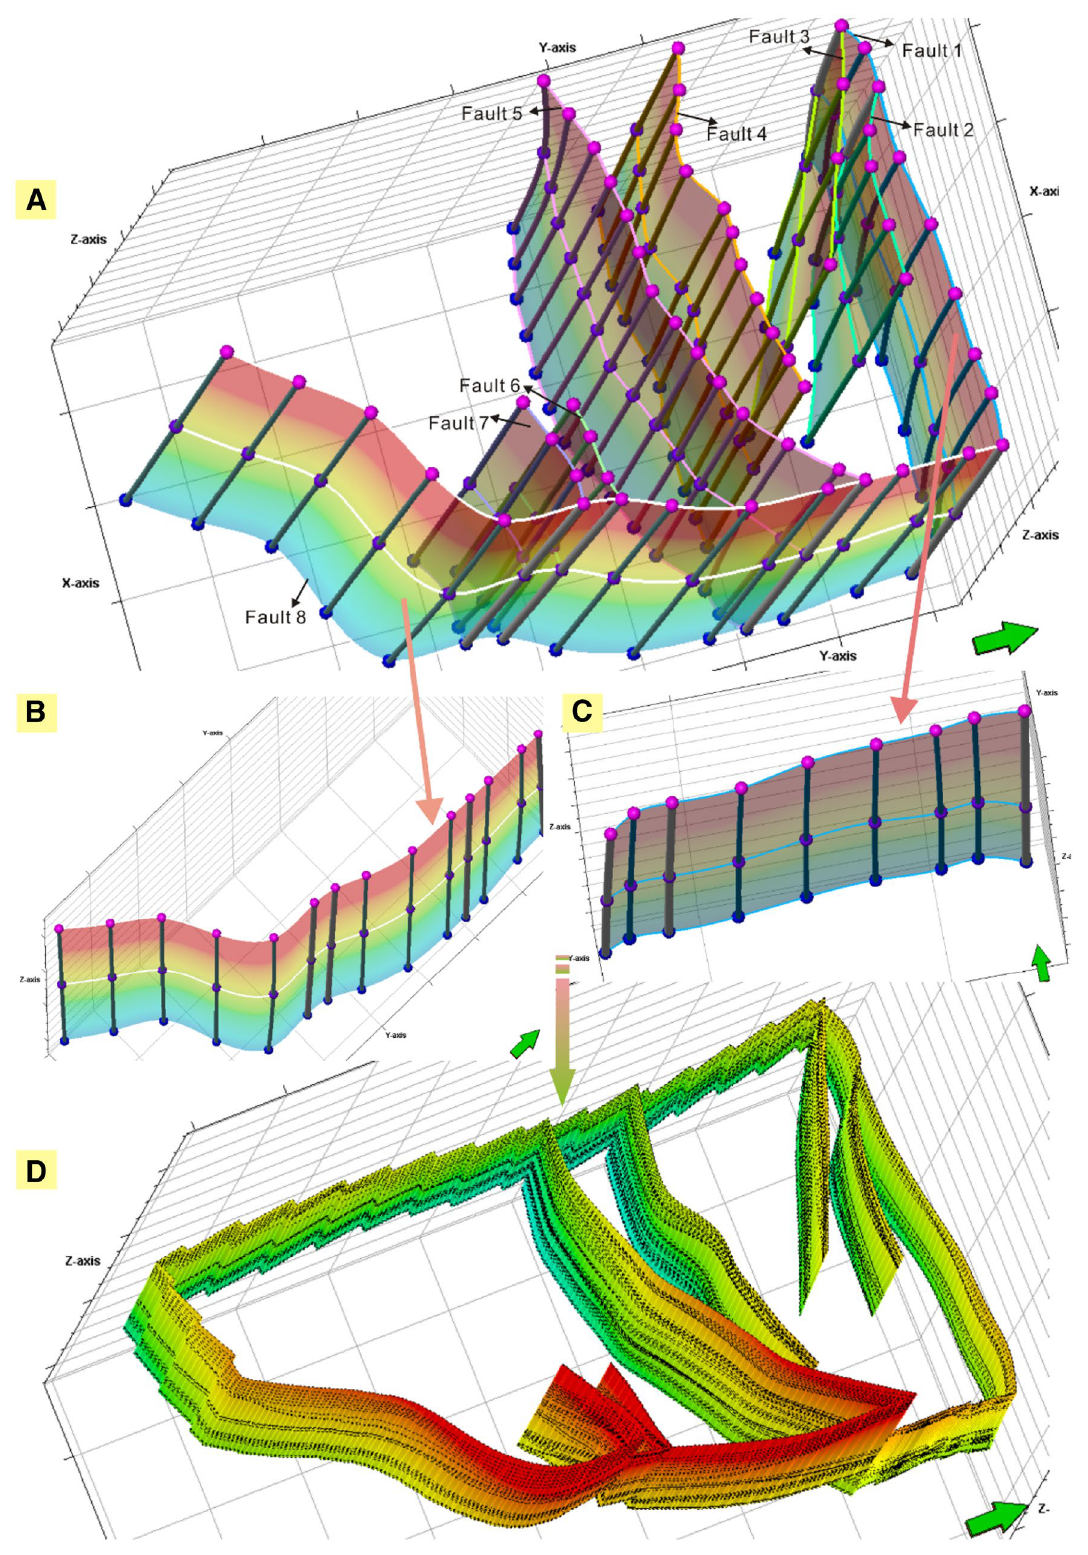
Fig. 4 3D fault model of the study area. a regional fault model established with minimum curvature method, showing the spatial distribution and the connection relationship between faults; b boundary fault No. 8; c boundary fault No. 1; 3D fault surface and the edges of modeling